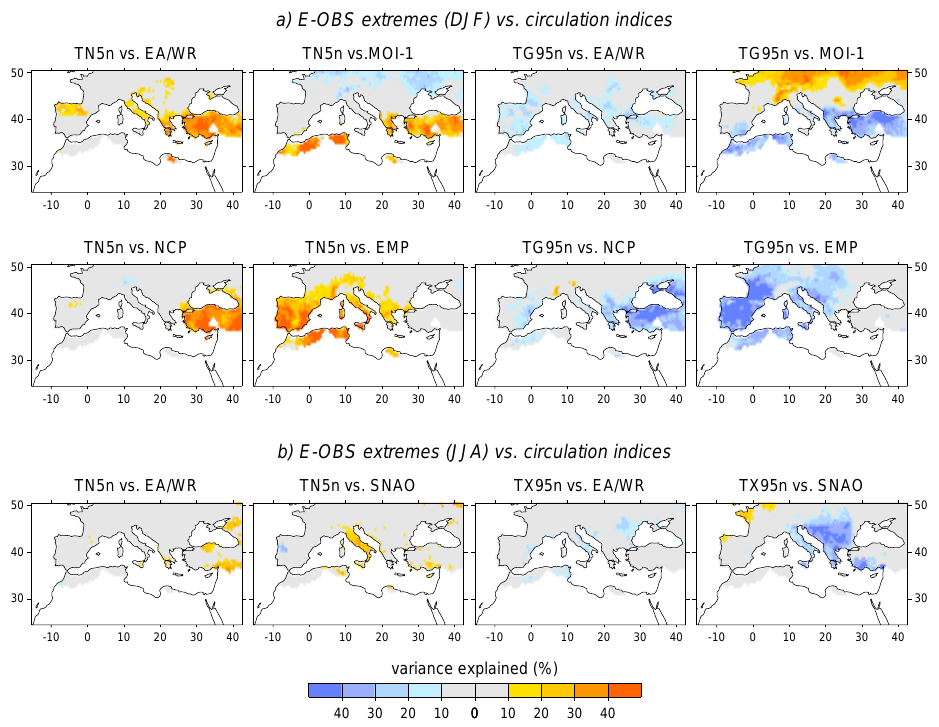
Fig. 8. Skill of the most important circulation indices for winter (upper two rows) and summer (bottom row) in explaining the variance (ex- pressed in %) of indices of temperature extremes (unfiltered time series) calculated from E-OBS (TN5n, TG95n, and TX95n) for 1958–2008. Red/blue shades indicate positive/negative relationships between circulation and indices of extremes (shown only for variance explained >